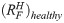
Effect of (RFH)healthy on hive population.